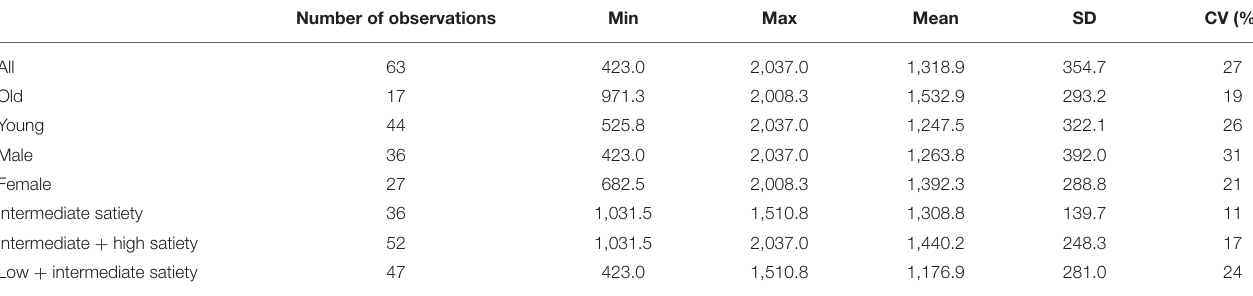
TABLE 1 | Overall satiety statistics for different participant groups. Number of observations